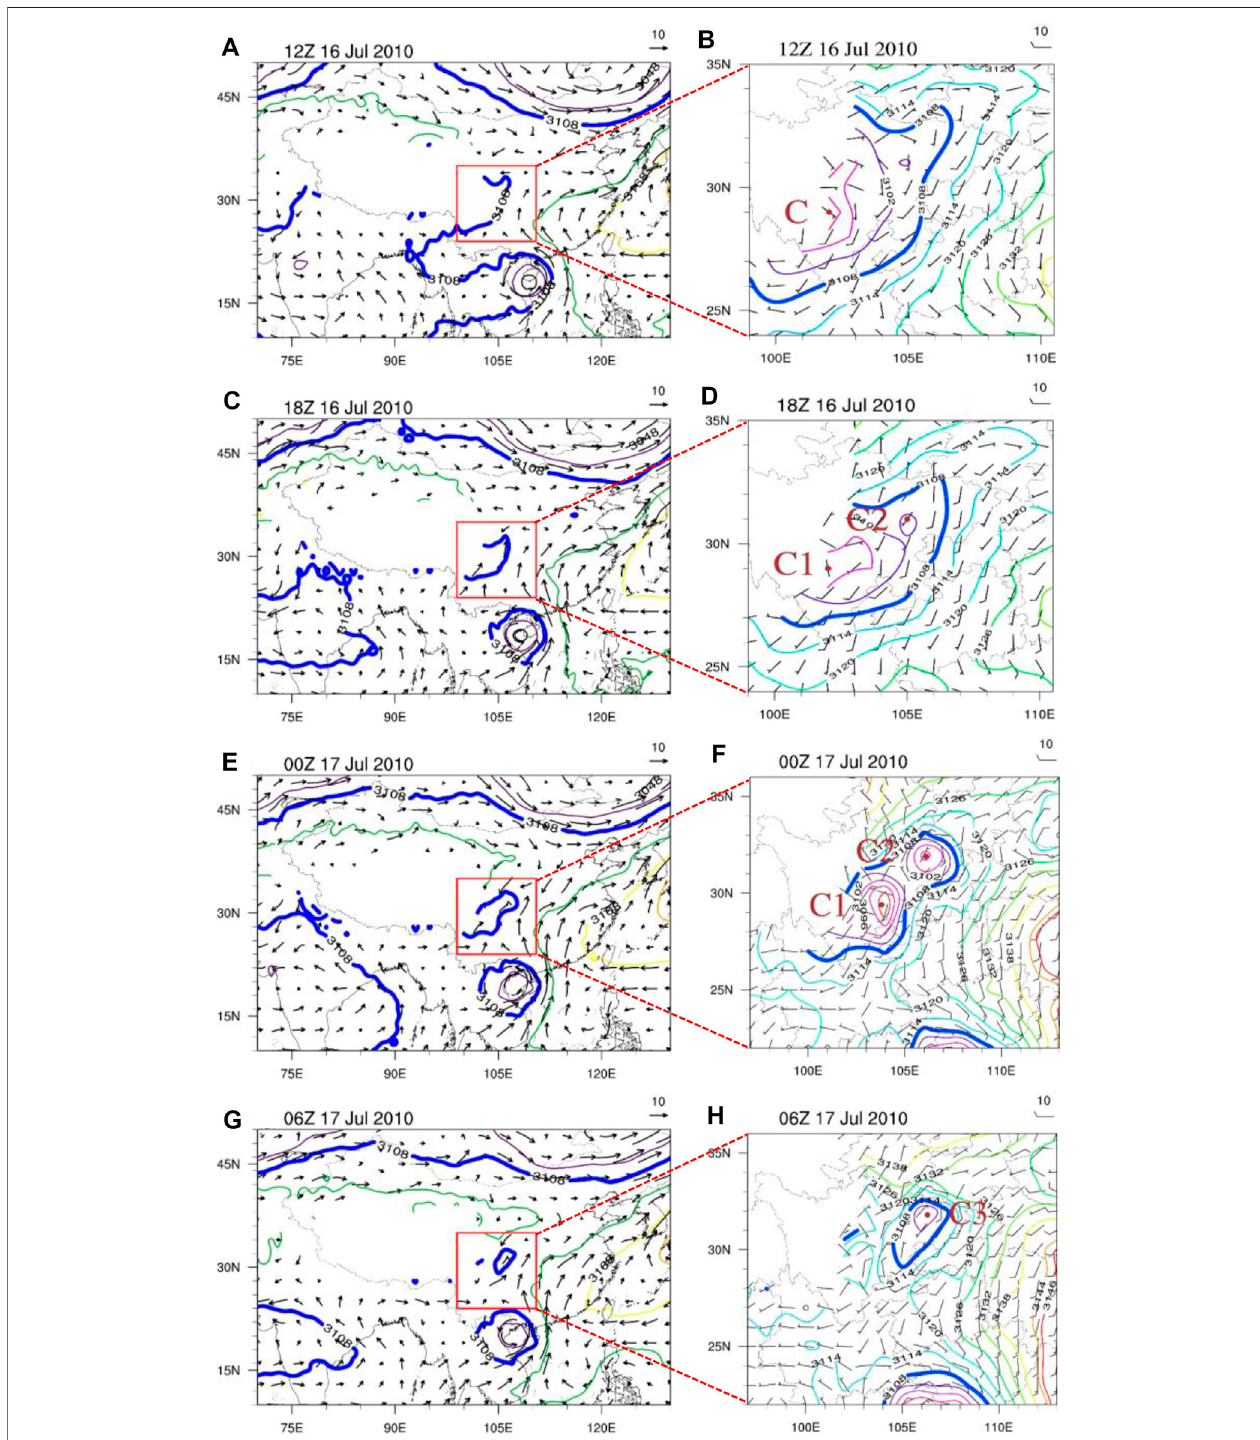
FIGURE 2 | Spatial distributions of the 700 hPa geopotential height (gpm, contours) and wind fi eld (m s − 1 , arrows) at (A,B) 12:00 UTC July 16, (C,D) 18:00 UTC July 16, (E,F) 00:00 UTC July 17, and (G,H) 06:00 UTC July 17. C, C1, C2, and C3 denote the southwest vortices (SWVs), and the brown dots represent their centers (the same in the following fi gures, if applicable).